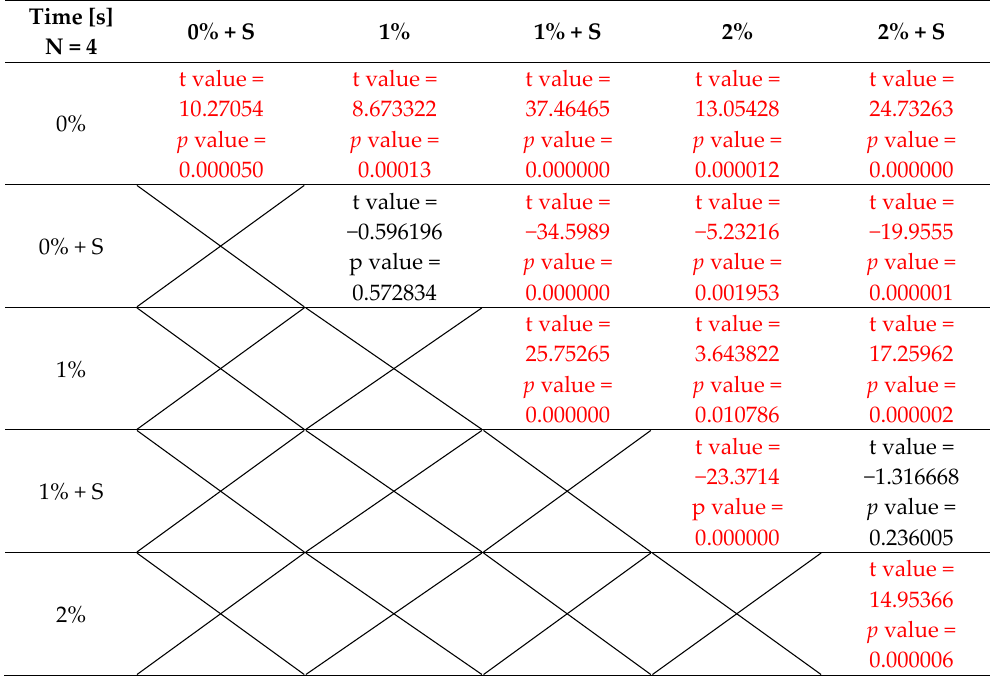
Table 6. Results of the polymerisation time of nanocomposites.